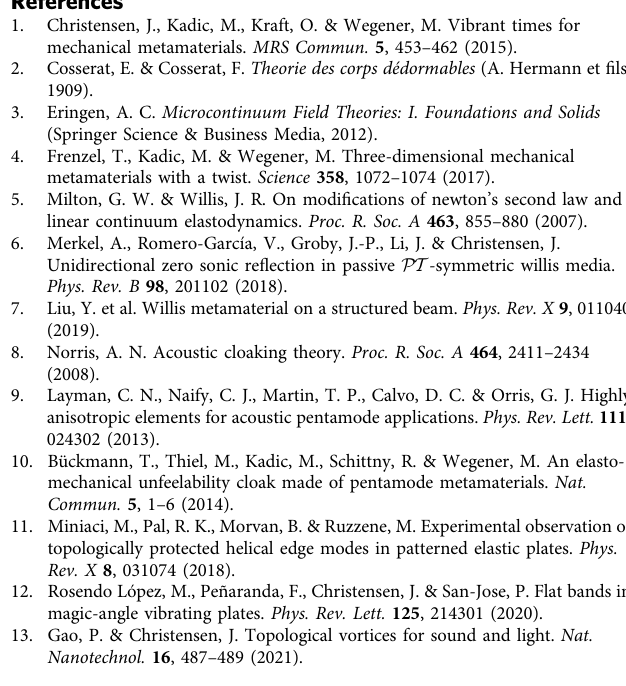
Figs. 1 – 3. In addition, fi nite-element-based computations were implemented to simulate elastic waves propagating in active media using the PDE module of the commercial solver package COMSOL Multiphysics. When considering the eigen- frequency analysis of the slab in Fig. 4a, the vertical sides are subject to periodic boundary condition while the horizontal surfaces are set to be stress-free. In Fig. 4b, c, all boundaries are assumed to be stress-free. Data availability